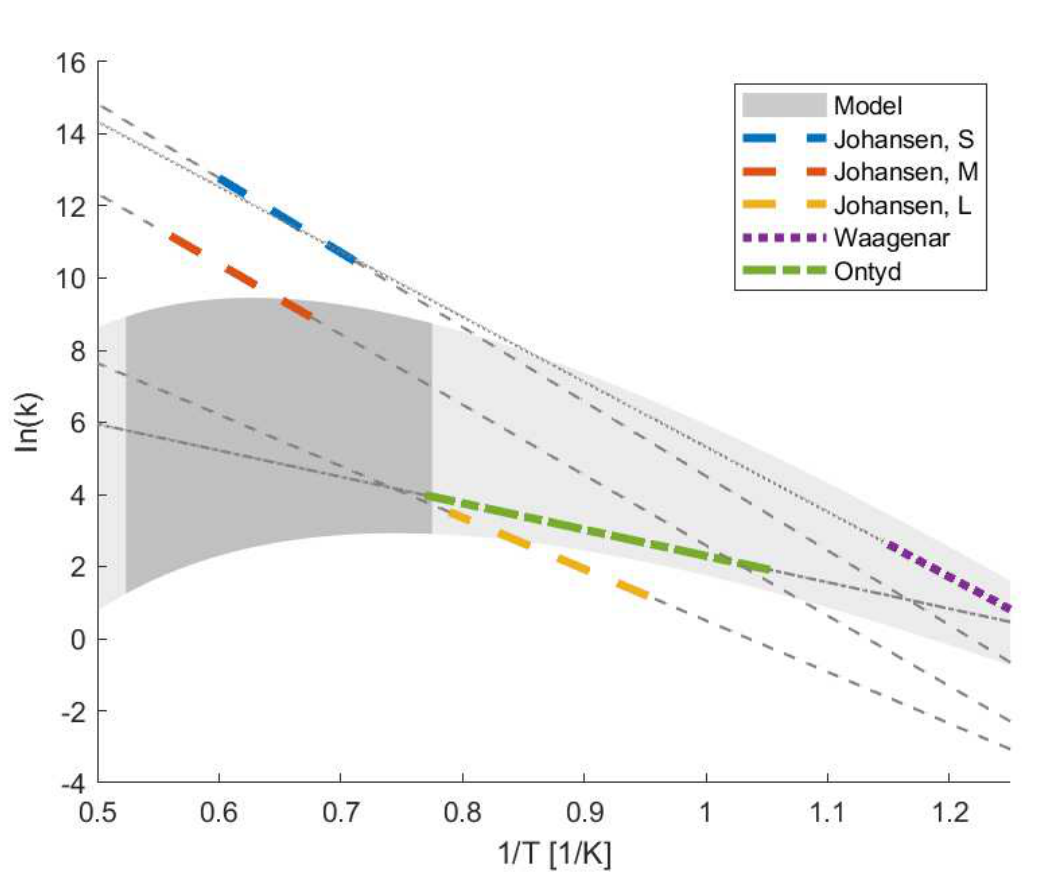
Figure 9. Arrhenius plot comparing the presented model to lumped kinetics literature data for small ( d p = 0–112 µ m), medium ( d p = 112–616 µ m), and large ( d p = 616–2000 µ m) particles from Johansen et al. [10]. This model accounting for both kinetics and heat transfer is based on experimental data from two single particle combustors (HR = 10 2 –10 3 , T g = 1480–1831 K, d p = 1790–5800 µ m), (HR = 30, T g = 1050–1267 K, d p = 10 900 µ m) and an entrained flow reactor (HR = 10 5 , T g = 1405–1667 K, d p = 63–90 µ m), and kinetic data from Wagenaar et al. [38] obtained in an entrained flow reactor (HR = 2–12 K/s, T g = 773–873 K, d p = 100–212 µ m), and parameters from Ontyd et al. [39] obtained in a drop tube reactor (HR 3.7 × 10 3 –7.8 × 10 3 K/s, T g = 950–1300 K, d p = 100 µ m). The reaction rate predicted by the model depends on particle size, density, and aspect ratio. Here, ln( k ) is shown for AR = 1 for comparative reasons, as the literature data are reported for spherical particles. The model’s ability to account for density and particle size changes means it covers a wider area, here shown in dark gray. Extrapolations of both the model presented here and literature models are shown in light